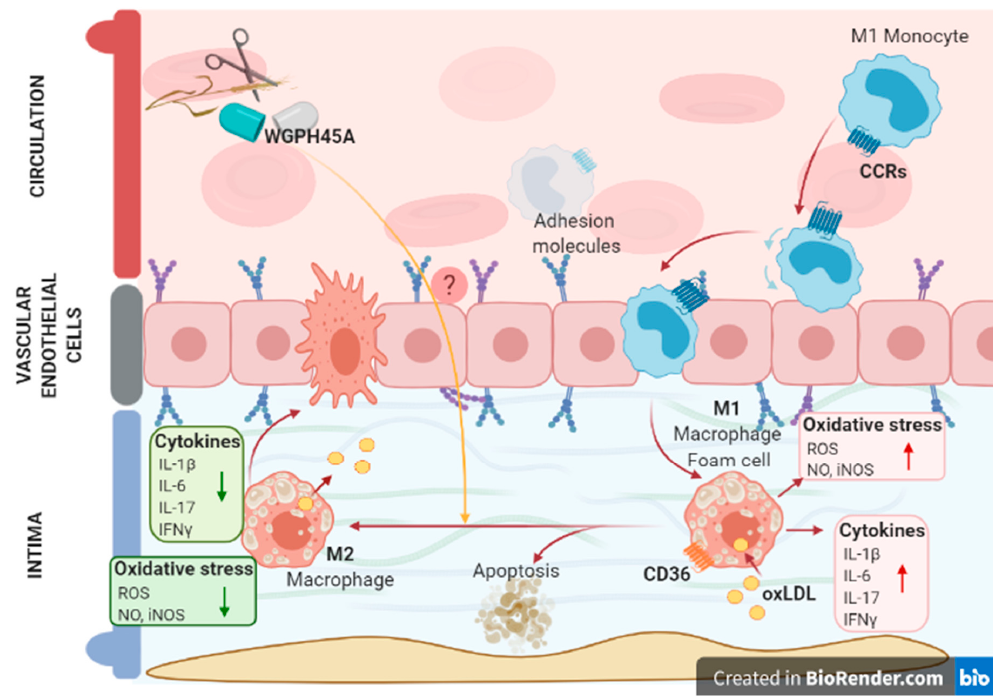
Figure 8. Summary of anti-oxidant, anti-inflammatory, and atheroprotective effects of WGPH45A in primary human monocytes. LPS-stimulated monocytes highly express the M1 phenotype, they used CCRs chemokines to infiltrate the intima, which is assisted by adhesion molecules. Once in the intima, monocytes differentiate into pro-inflammatory macrophages. In the intima, macrophages react to atherogenic lipoproteins (ox-LDL) via pinocytosis by scavenger receptor pathways (CD36), resulting in the foam cell formation. These cells cause oxidative stress and enhance pro-inflammatory cytokine production, which may lead to death by apoptosis in the necrotic core of the plaque. When WGPH45A is added, the foam cell may cause the efflux of ox-LDL and induce the transition to the M2 phenotype, which is characterized by the resolution of inflammation and tissue repair.